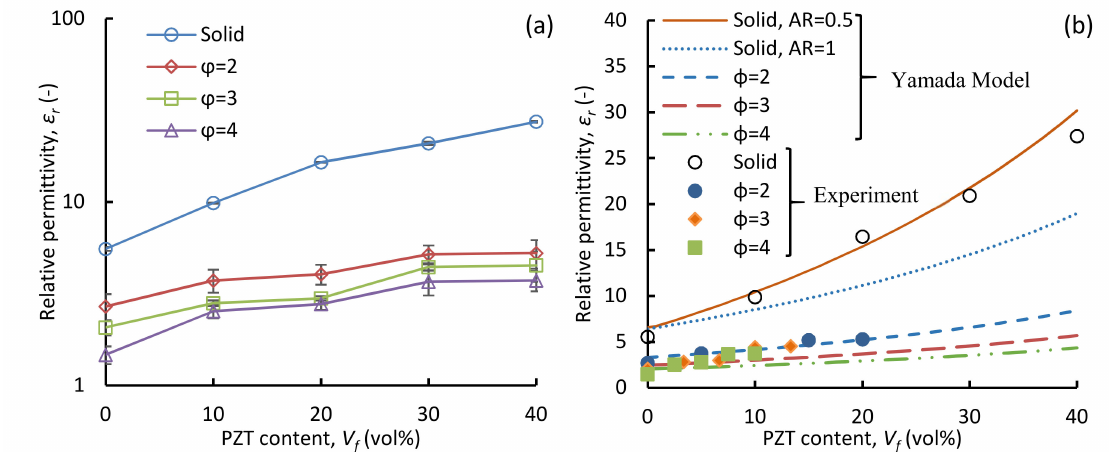
Figure 7. ( a ) Relative permittivity of TPU/PZT composites as a function of PZT content at the expansion ratios (void fractions) of ϕ = 2 ( V f = 0.5), ϕ = 3 ( V f = 0.67), ϕ = 4 ( V f = 0.75). ( b ) Relative permittivity vs. PZT content for solid and foam TPU/PZT samples, compared with the prediction of the Yamada